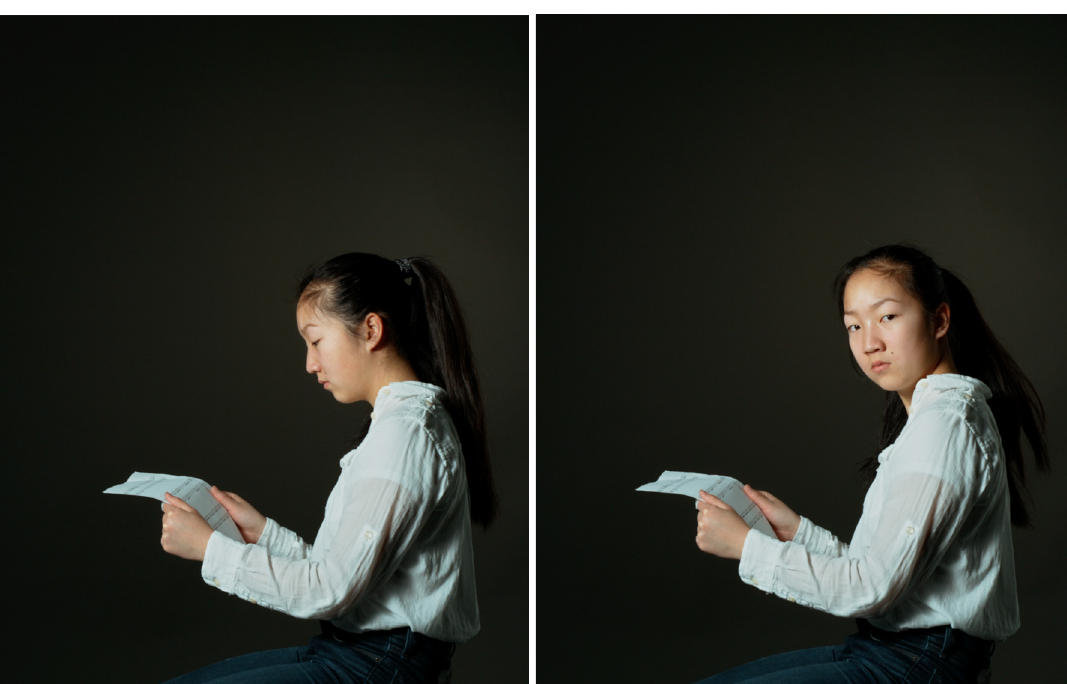
Figs. 12, 13 Jeannette Christensen, Woman Interrupted (Meili), video stills 2018 We see that the figure’s body and attention are divided. Even though the face and the eyes are facing the viewer, the body and much of the attention are facing the sheet of notes, or perhaps the letter that, on a diegetic level, upon being delivered already interrupted the music. This dividedness raises the question